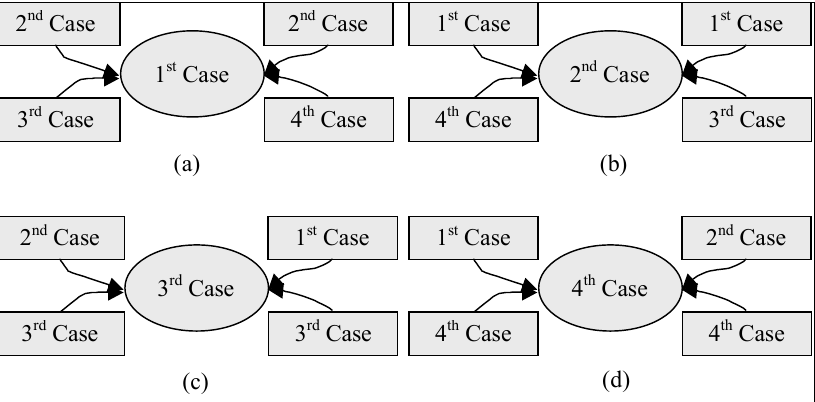
Fig. 5 – Connections between road